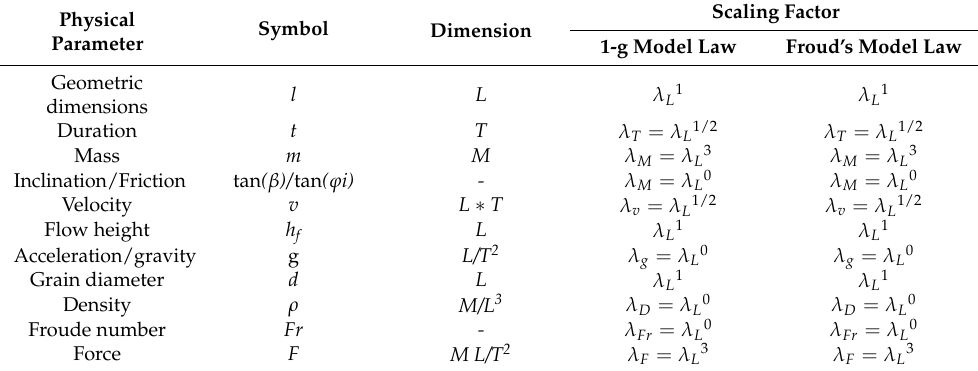
Table 5. List of scale factors λ i based on the 1-g model law and Froude’s model